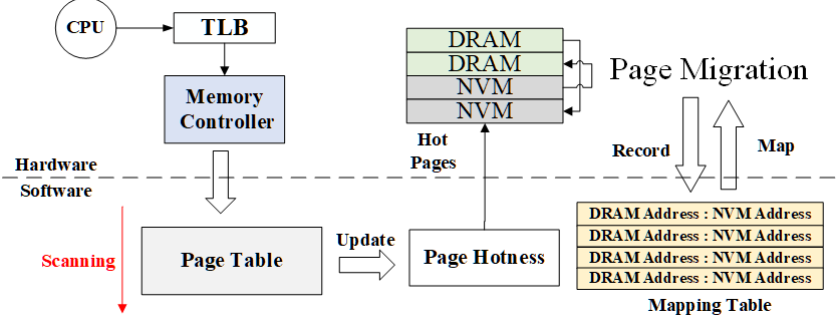
Figure 2. Architecture of